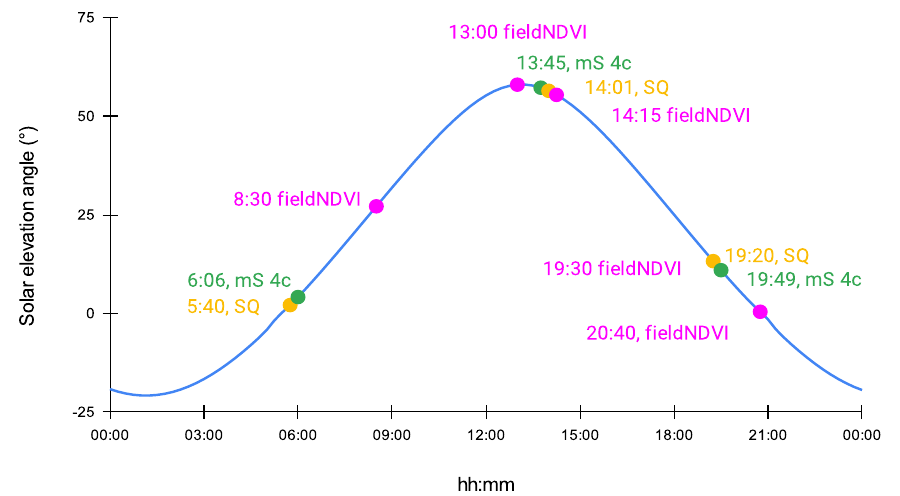
Figure 4. Time schedule of the aerial flights and in situ measurements mapped on a chart together with the solar elevation for that day, 29 July 2020.